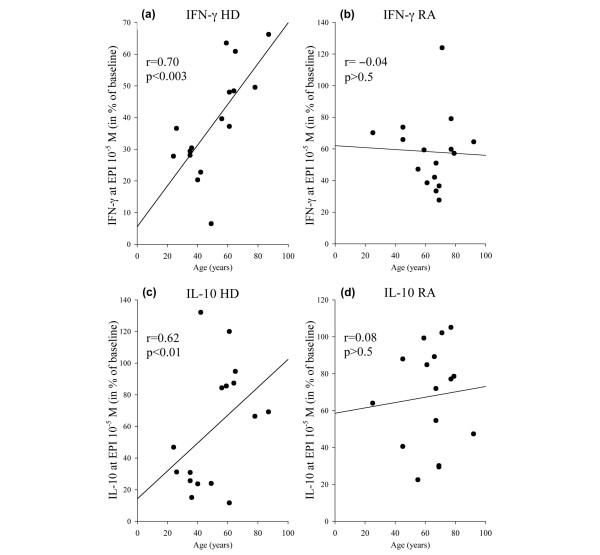
Correlation between age and epinephrine (EPI) effects in patients with rheumatoid arthritis (RA) and healthy subjects. The age of the subjects was plotted against concentrations of the relative interferon (IFN)-γ in (a) healthy donors (HDs) and (b) patients with RA and of interleukin (IL)-10 in (c) HDs and (d) patients with RA after co-incubation of activated T cells with 10-5 M EPI for 48 hours. The baseline values of each HD and patient with RA were defined as 100%. (Concentrations are presented in Figure 1 legend.) The cytokine concentrations upon co-incubation with 10-5 M EPI are given as percentage of baseline values. p, the p value; r, the respective correlation coefficient.